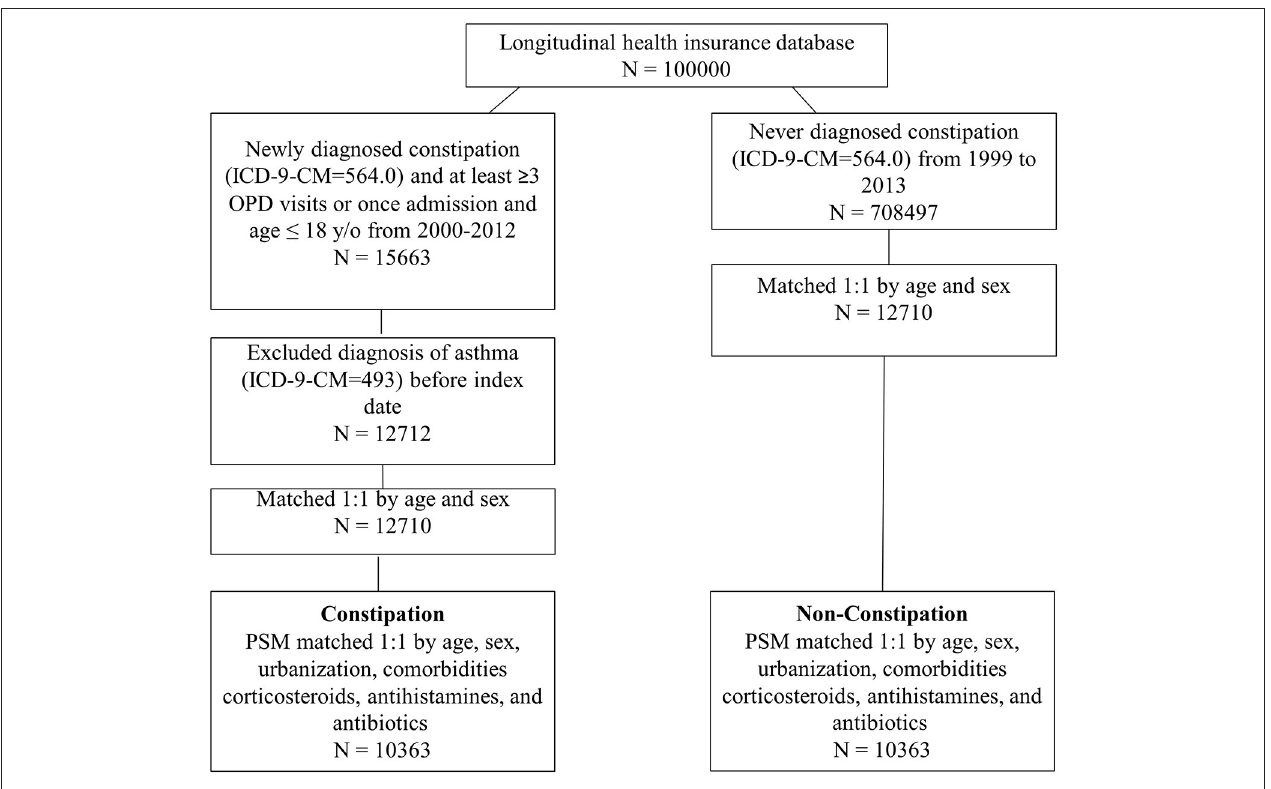
FIGURE 1 | Flowchart of enrolment of constipation and non-constipation groups.